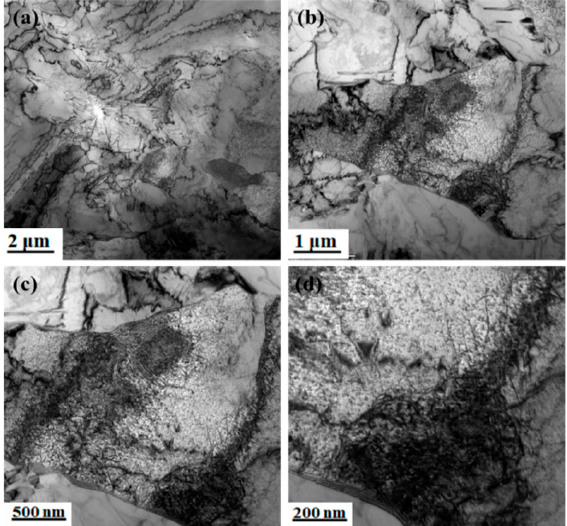
Figure 6. Dislocation density distribution on the matrix (650 °C). ( a ) Morphology of the dislocation density distribution, ( b – d ) enlarged figure.